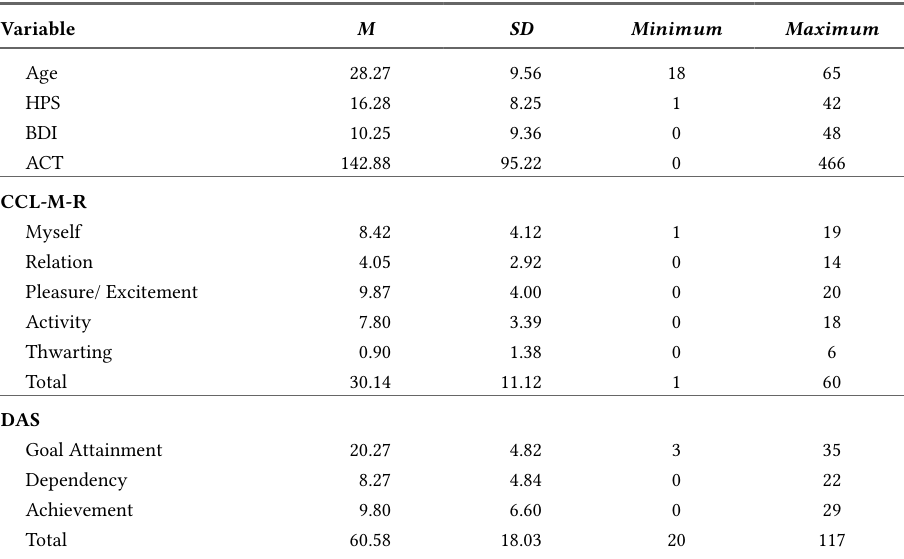
Characteristics of the Sample (N = 255)